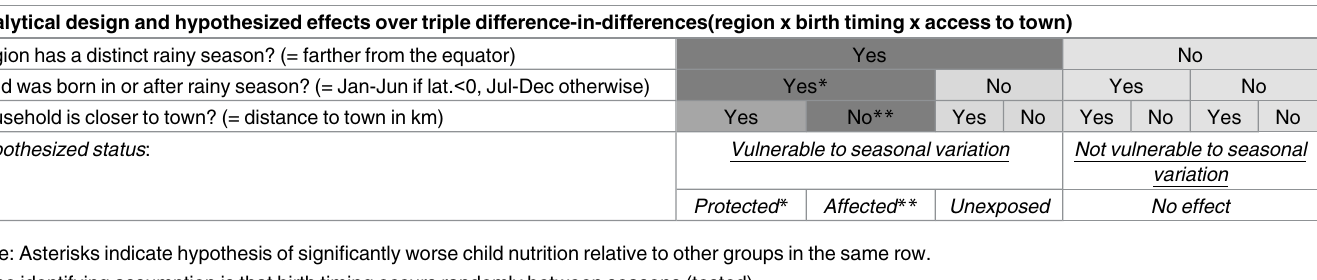
Table 1. Spatial variation in exposure to seasons, birth timing and accessto